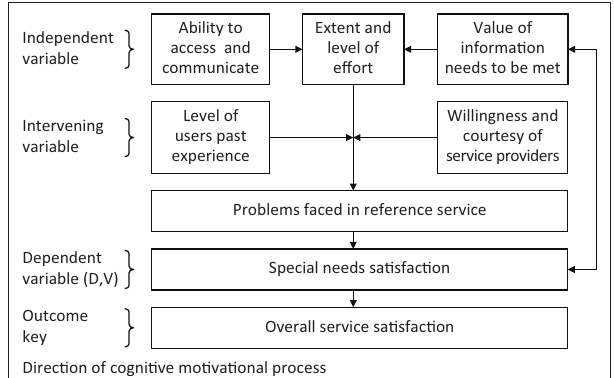
FIGURE 1: Conceptual